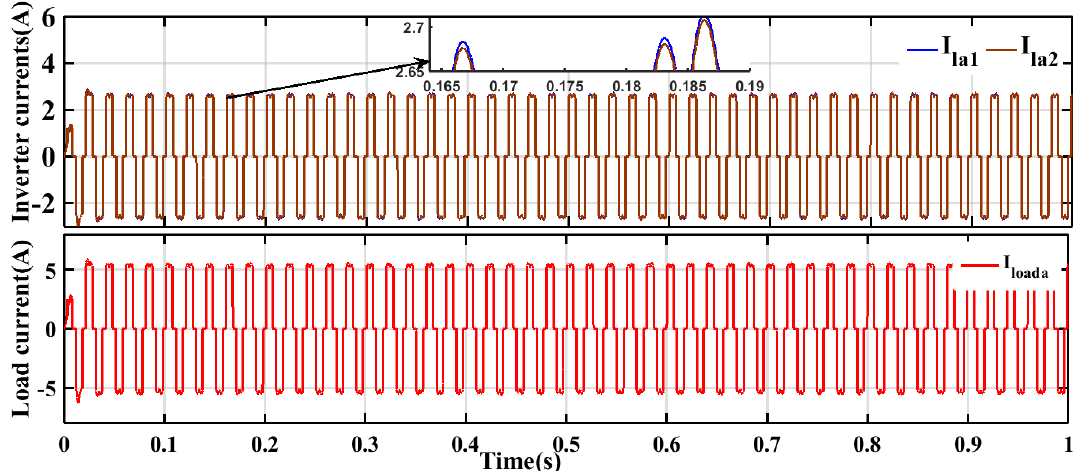
Figure 14. Current sharing with proposed method with nonlinear load.